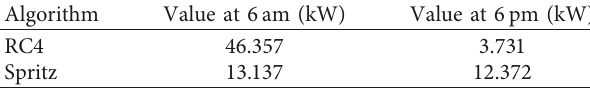
Table 2: Test data points for RC4 and Spritz.